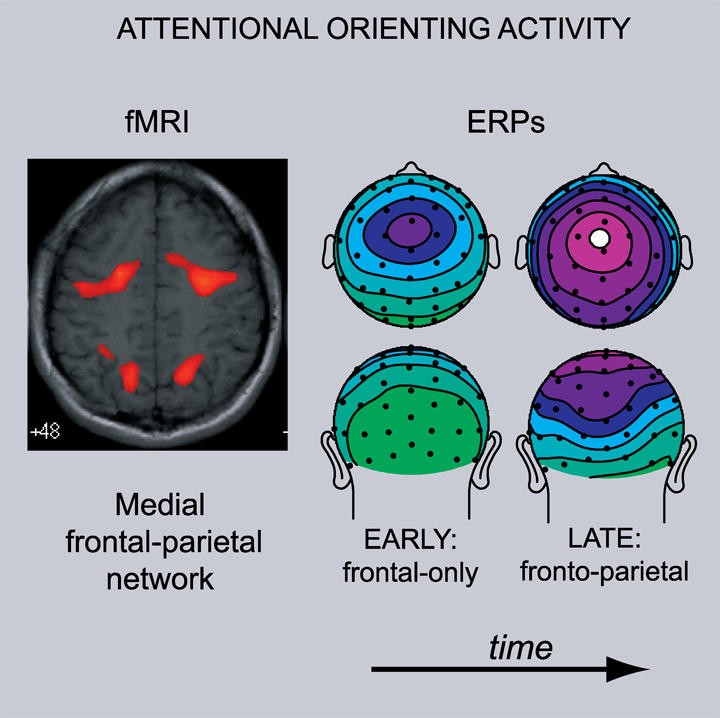
Within the medial frontal-parietal attentional control network (fMRI activations, left column), the frontal areas (ERPs, middle column) activate earlier than the parietal areas (ERPs, right column).